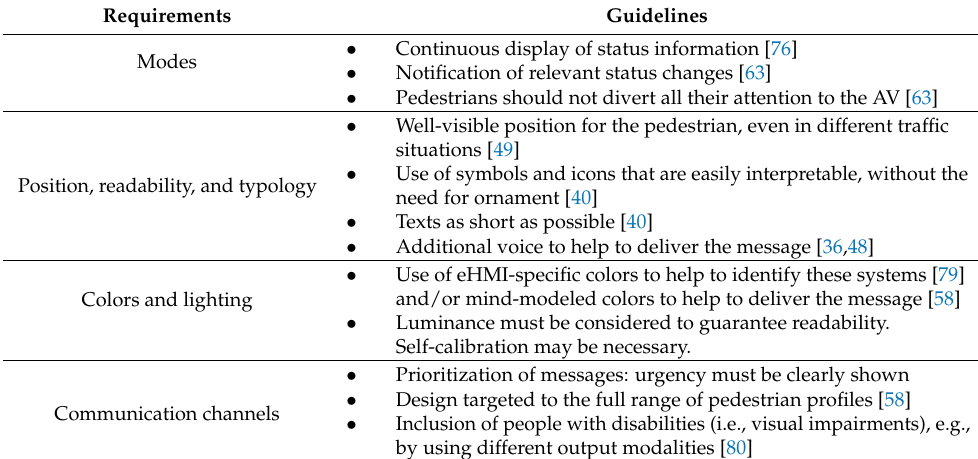
Table 3. Summary of the guidelines obtained from the literature